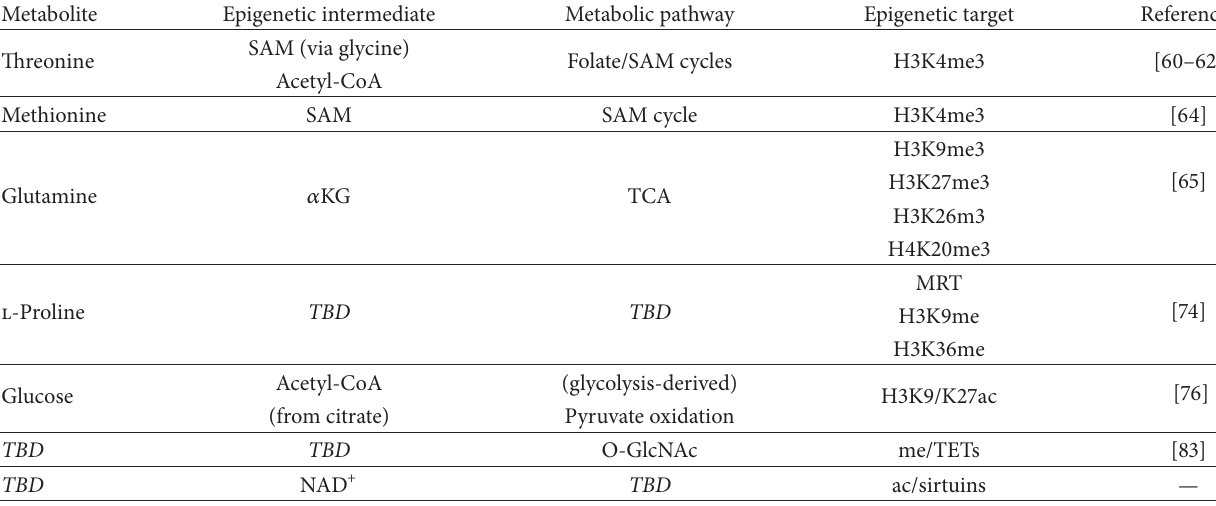
Table 1: Summary of metabolites linked with epigenetic modifications in pluripotent stem